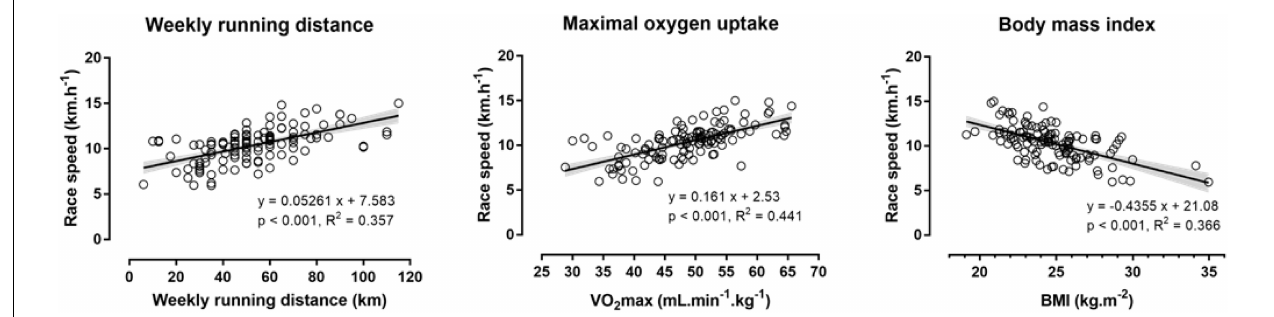
FIGURE 1 | Relationship of race speed with weekly running distance, maximal oxygen uptake, and body mass index in the total sample of male marathon runners ( n = 130). VO 2 max, maximal oxygen uptake; BMI, body mass index. The shaded band around the regression line denotes the 95% confidence interval on this line.